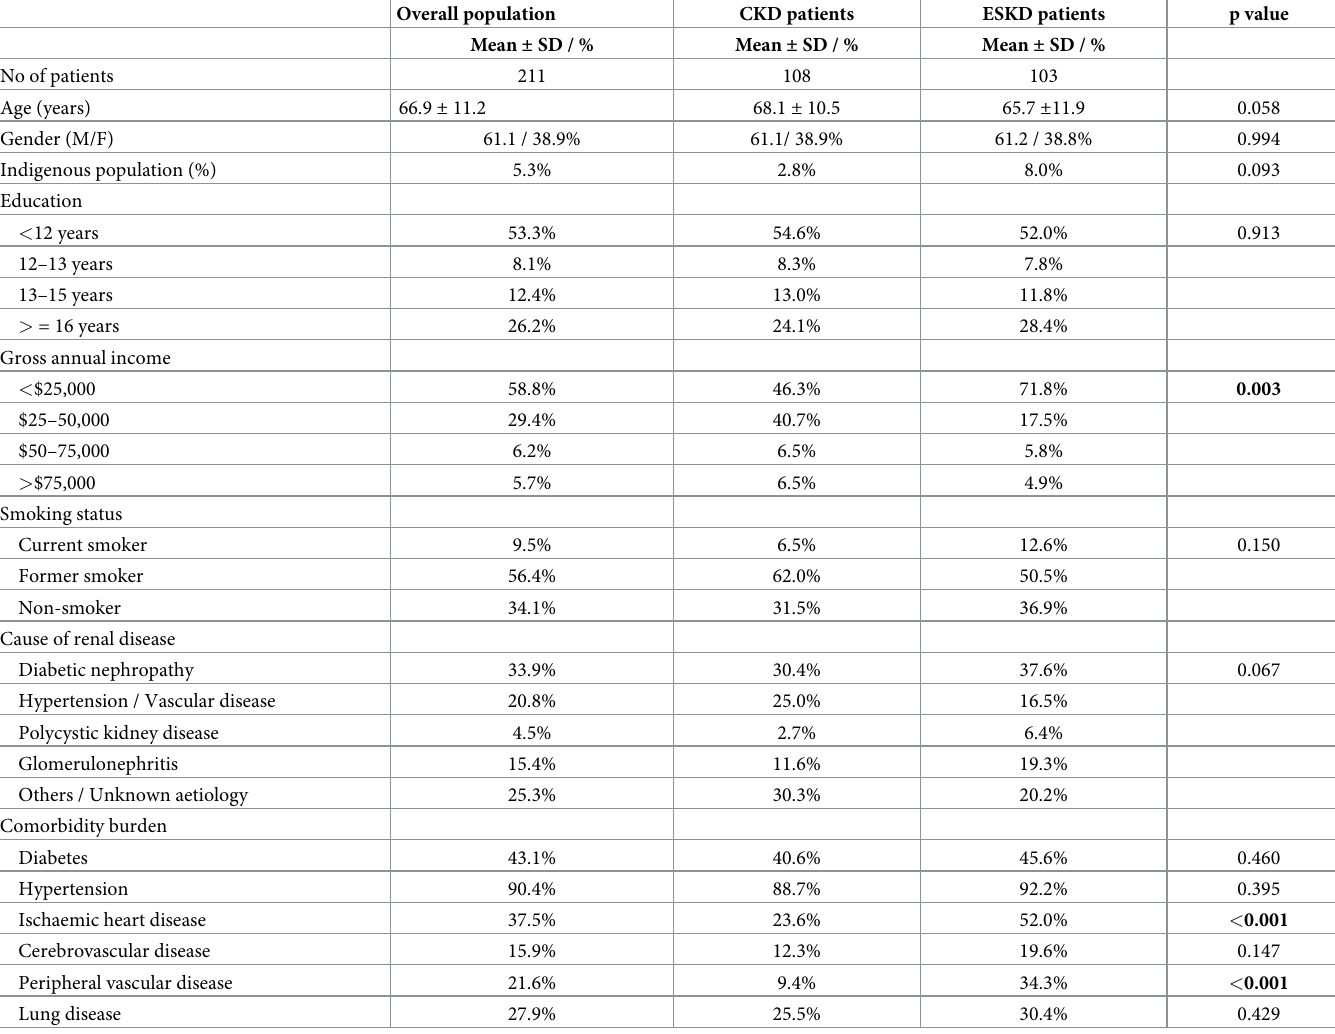
Table 1. Baseline demographic and clinical characteristics of the study population comparing non-dialysis CKD and ESKD